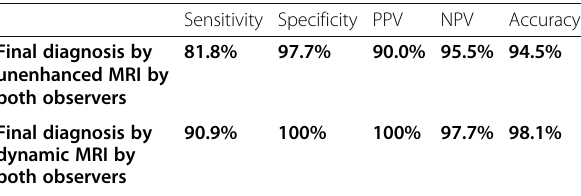
Table 4 Showed final unenhanced MRI diagnosis by both observers and interobserver agreement